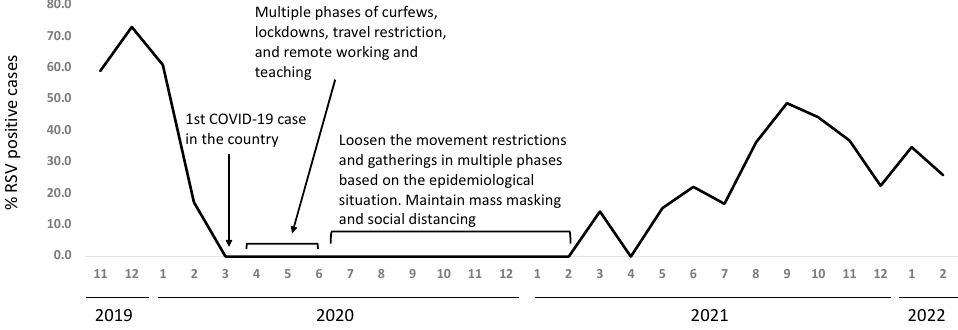
Figure 2. Seasonal pattern of RSV infection during and after the COVID-19 pandemic.